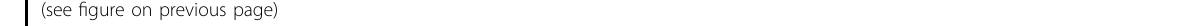
Fig. 4 CRO15 treatment induces p53 pathway activation. A Indicated melanoma cell lines were treated with 5 μ M CRO15 for 48 h before viable cells were counted using the trypan blue dye exclusion method. B A375 cells were treated with 5 μ M CRO15 for the indicated duration, and lysates were analyzed by western blotting with indication antibodies. One representative experiment of three is shown. C Luciferase activity in A375 cells transfected with a p53 luciferase reporter upon 5 μ M CRO15 treatment or actinomycin used as a positive control for p53 induction. D (left part) A375 cells were transfected with sip53 and then treated with 5 μ M CRO15. After 24 h of treatment, viable cells were counted using the trypan blue exclusion method. The results are expressed as percentages of the DMSO control. (Right part) SK-MEL-28 cells were infected with control or p53- encoding adenoviruses and transfected with a p53 luciferase reporter. Cells were treated 24H with 5 μ M CRO15 and a luciferase assay was performed. E A375 cells were transfected with control or p53 siRNA and treated with 5 μ M CRO15 for the indicated duration. Lysates were analyzed by western blotting with the indicated antibodies. One representative experiment of three is shown. For C and D , data given as the means ± SEM of three independent experiments performed in triplicate. * p < 0.05; ** p < 0.01; *** p <